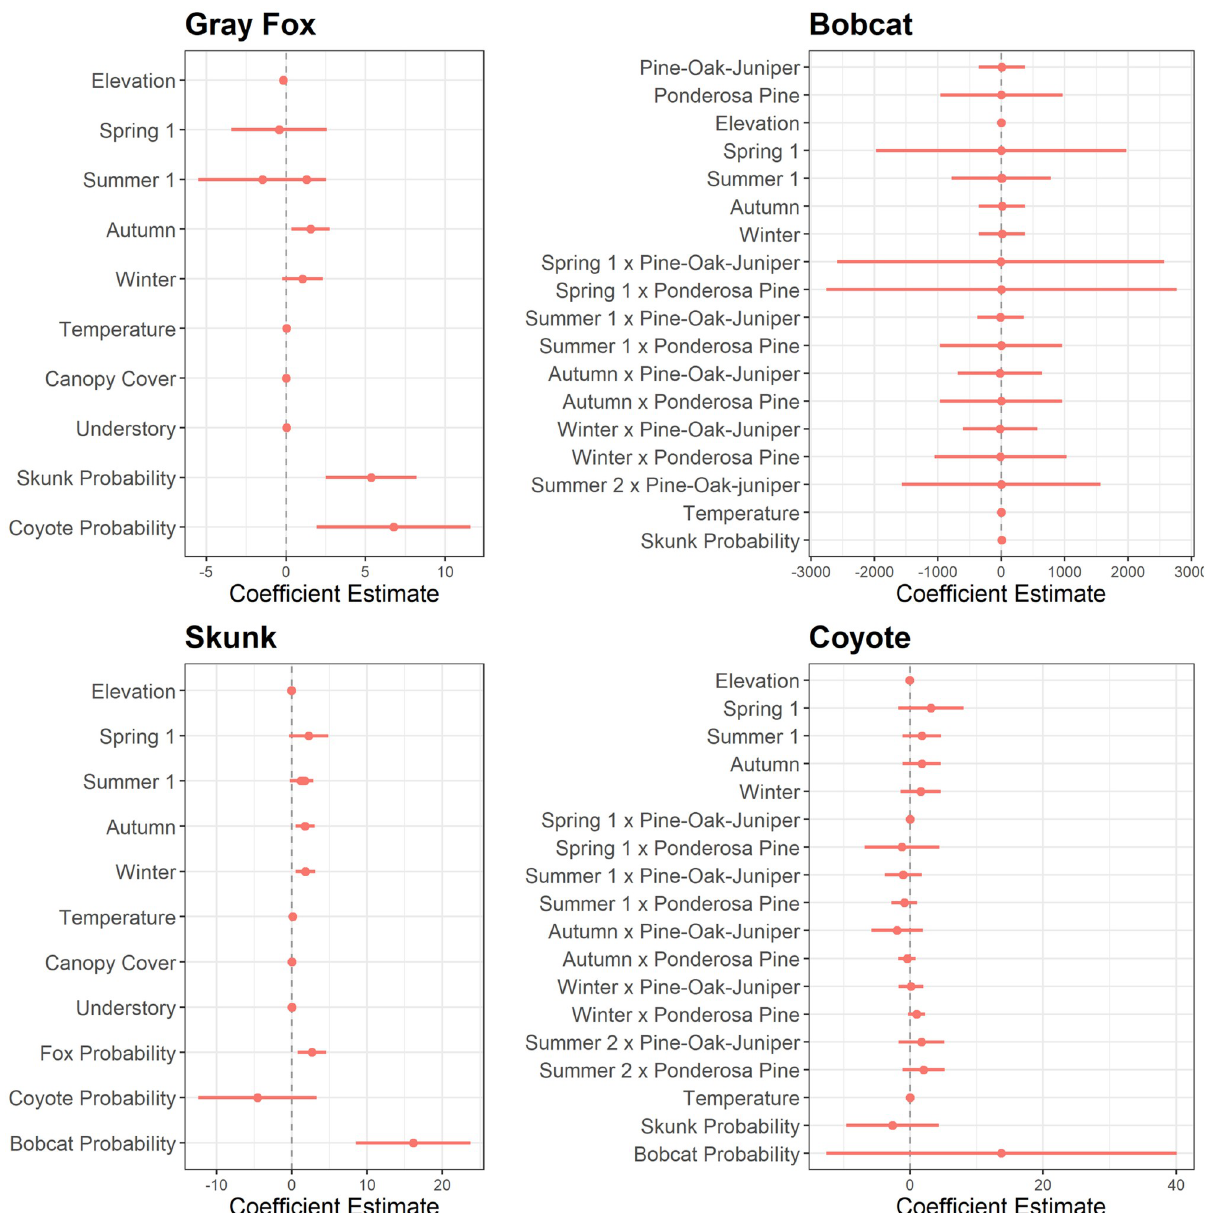
Fig 2. Beta estimates for best fit model from stage 2 (multi-species co-occurrence) for each mesocarnivore. We compared the beta estimate for each variable to zero with a 95% confidence interval to determine if the variable positively or negatively influenced probability of detection. The x-axis depicts beta estimates for each coefficient and the y-axis shows all coefficients included in the best fit stage 2 model for each mesocarnivore (gray fox, skunk, bobcat, coyote).